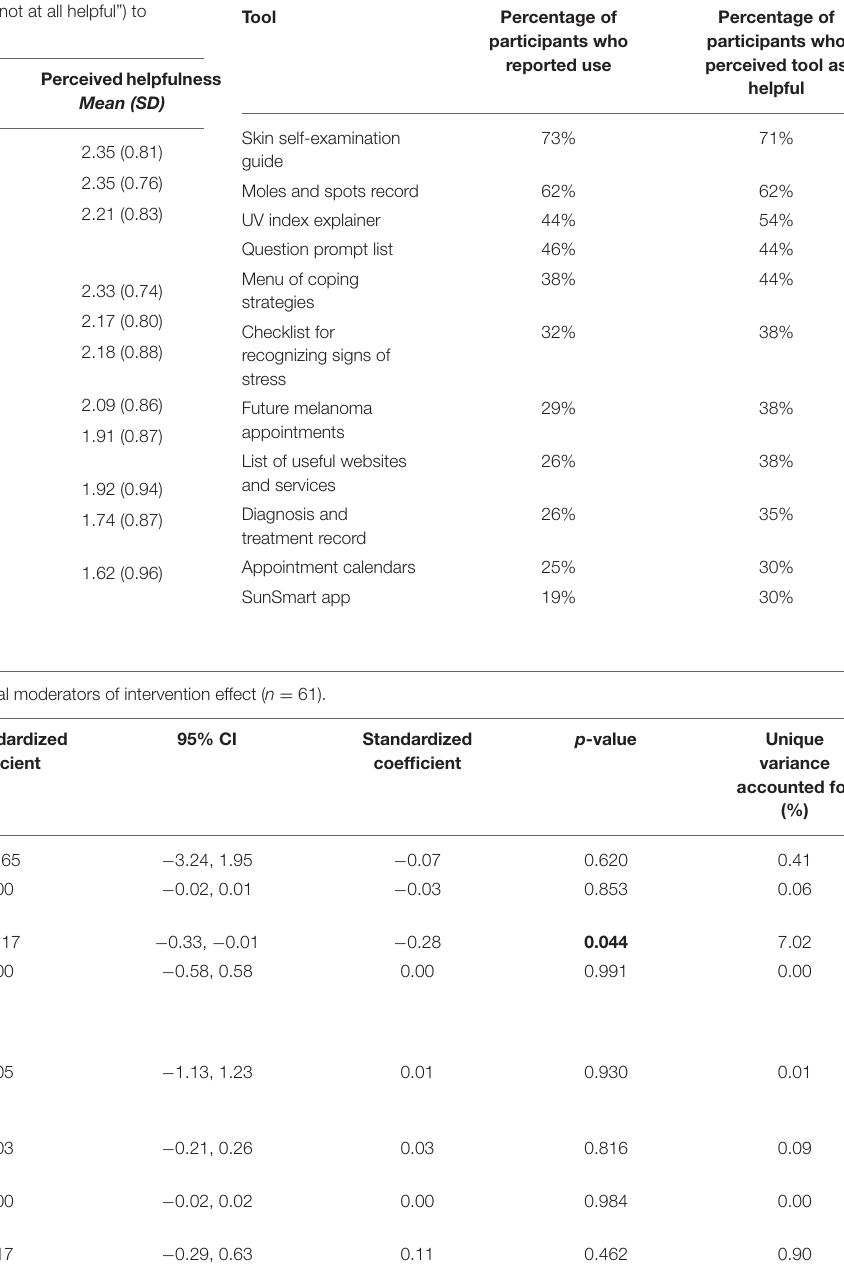
TABLE 5 | Reported use and perceived helpfulness of the tools included in Melanoma: Questions and Answers ( n = 69).